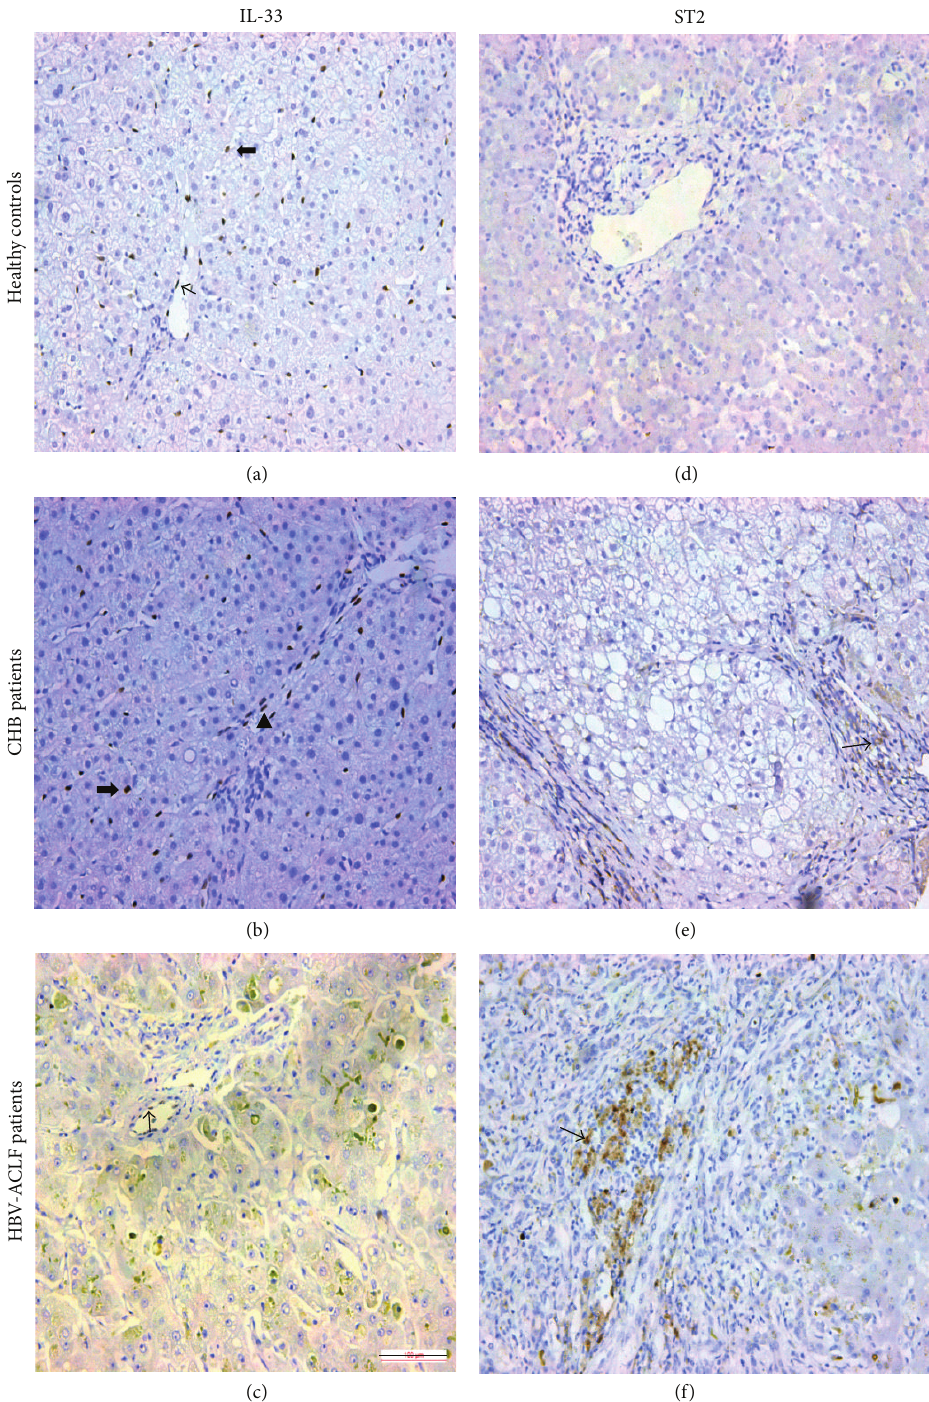
Figure 2: Expression of IL-33 and ST2 in liver specimens of hepatitis B virus-related acute-on-chronic liver failure (HBV-ACLF) patients, chronic hepatitis B (CHB) patients, and healthy controls. Immunohistochemical staining was performed with anti-IL33 (a–c) or anti-ST2 protein(d–f)antibodies.CellsthatstainedpositiveforIL-33areindicatedwithnarrowarrows(endothelialcells)(a,c),widearrows(sinusoidal cells) (a, b), or arrowhead (fibrous scar cells) (b). Narrow arrows in e and f indicate infiltrating ST2 + cells. Scale bar = 100 𝜇